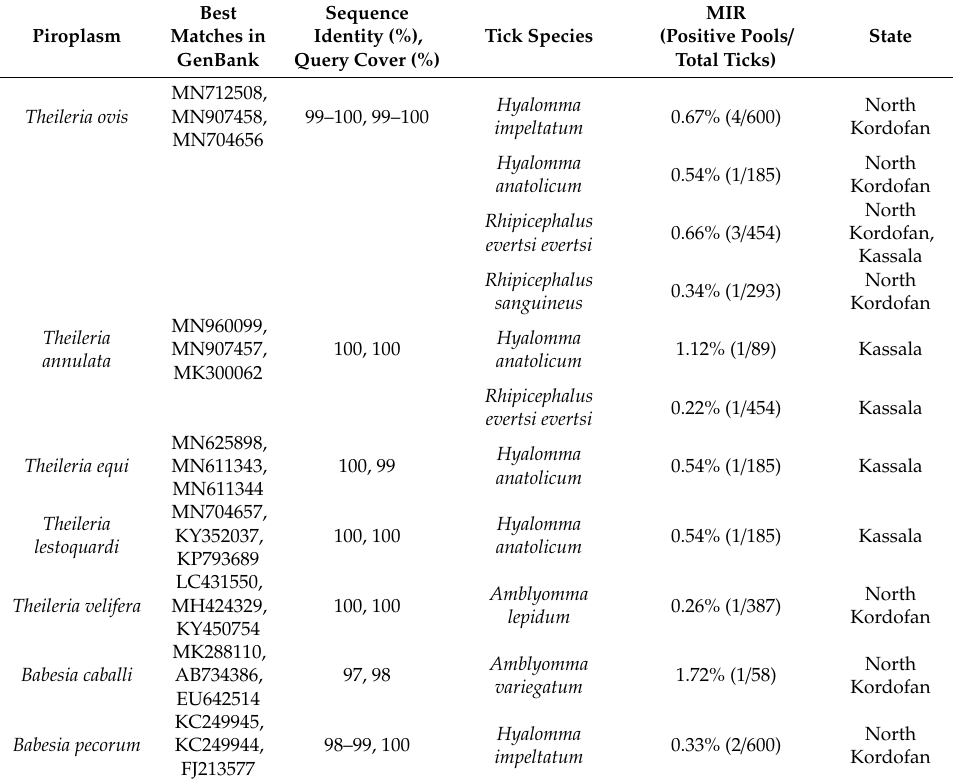
Table 2. Babesia spp. and Theileria spp. identified in di ff erent tick species collected from livestock and other domestic animals in Sudan from January to August